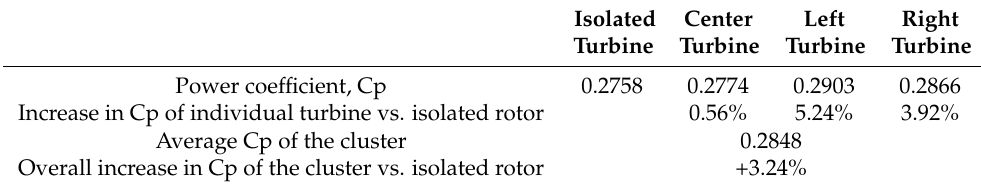
Table 3. Simulation results at 8 turbine diameter spacing.